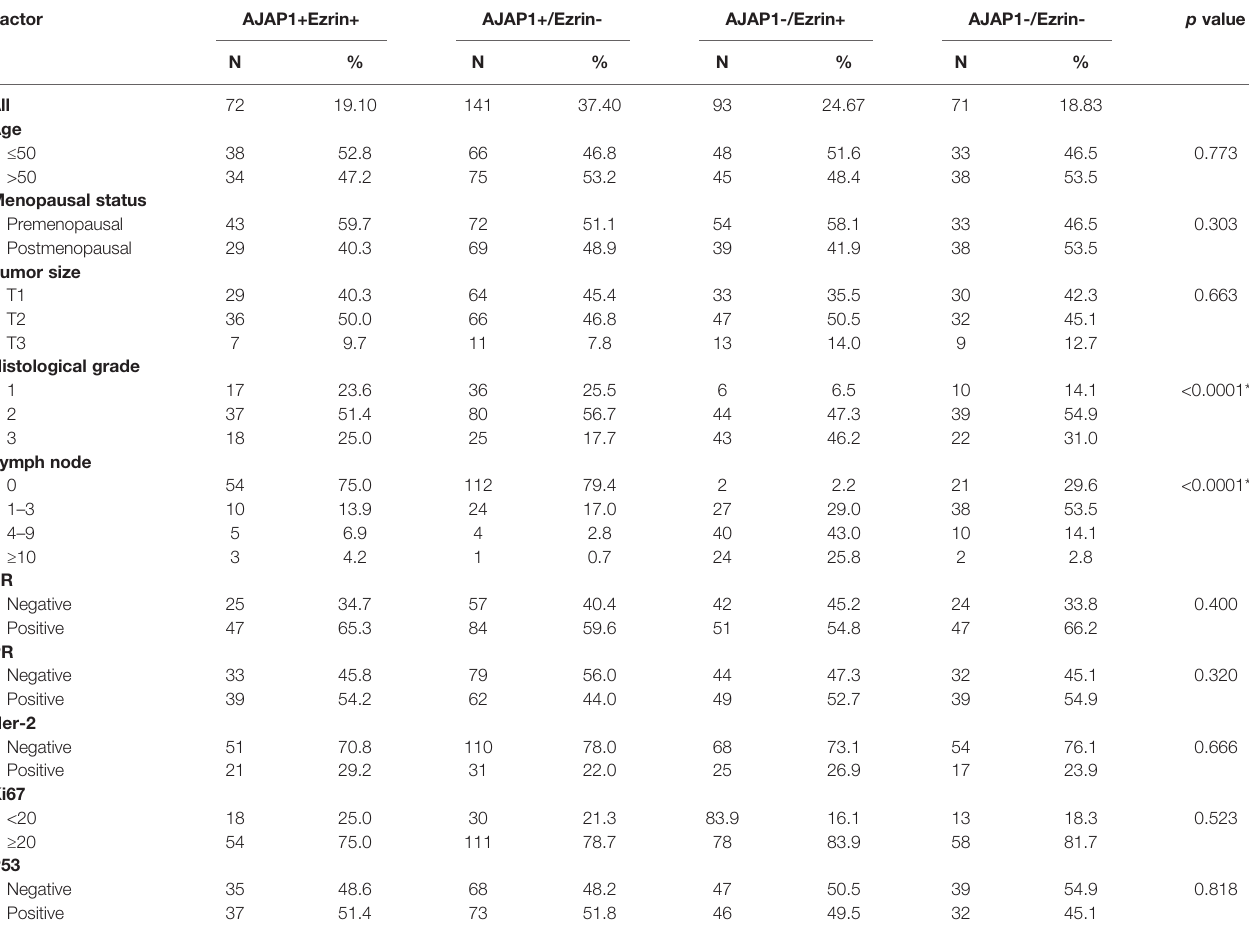
TABLE 2 | AJAP1/Ezrin expression and clinicopathological parameter in patients with breast cancer patients.